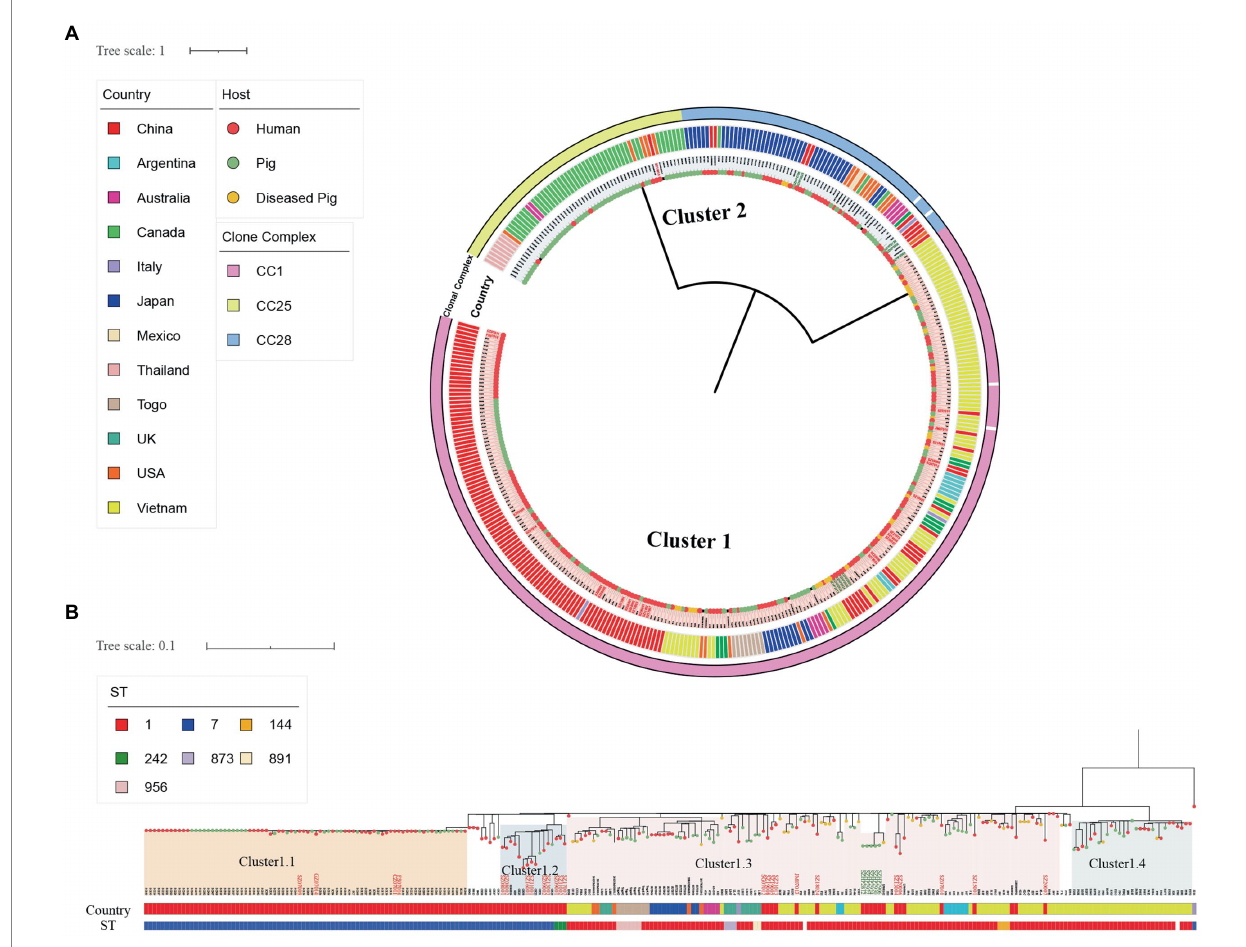
FIGURE 2 Single-nucleotide polymorphism-based global S. suis 2 Ml tree. (A) SNP-based global S. suis 2 Ml tree includes 25 human isolates (red font) and 10 swine isolates (green font) from Shenzhen, and 345 S. suis isolates downloaded from the NCBI database. The different colored circles on each branch represent different host sources, and the circles represent clonal complex, country, or cluster as indicated on the figure. (B) SNP-based global S. suis 2 Cluster1 ML tree includes 24 human isolates (red font) and five swine isolates (green font) from Shenzhen, and 224 S. suis isolates downloaded from the NCBI database. The country and host legends of the isolates are the same as on (A) . ST or cluster as indicated on the